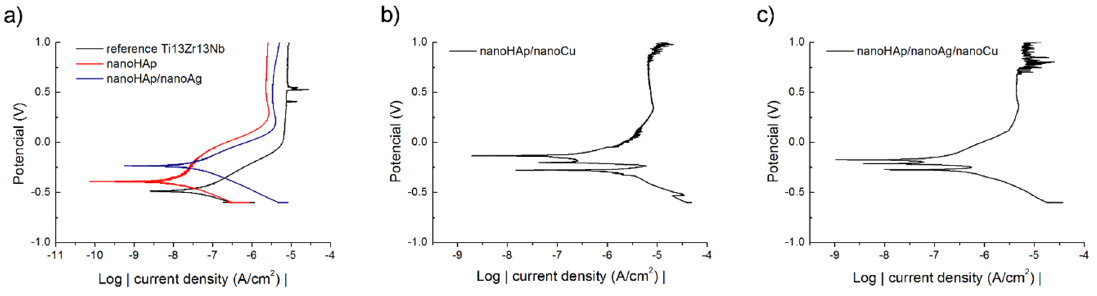
Figure 1. SEM images of the: ( a ) nanoHAp, ( b ) nanoHAp/nanoAg, ( c ) nanoHAp/nanoCu, and ( d )